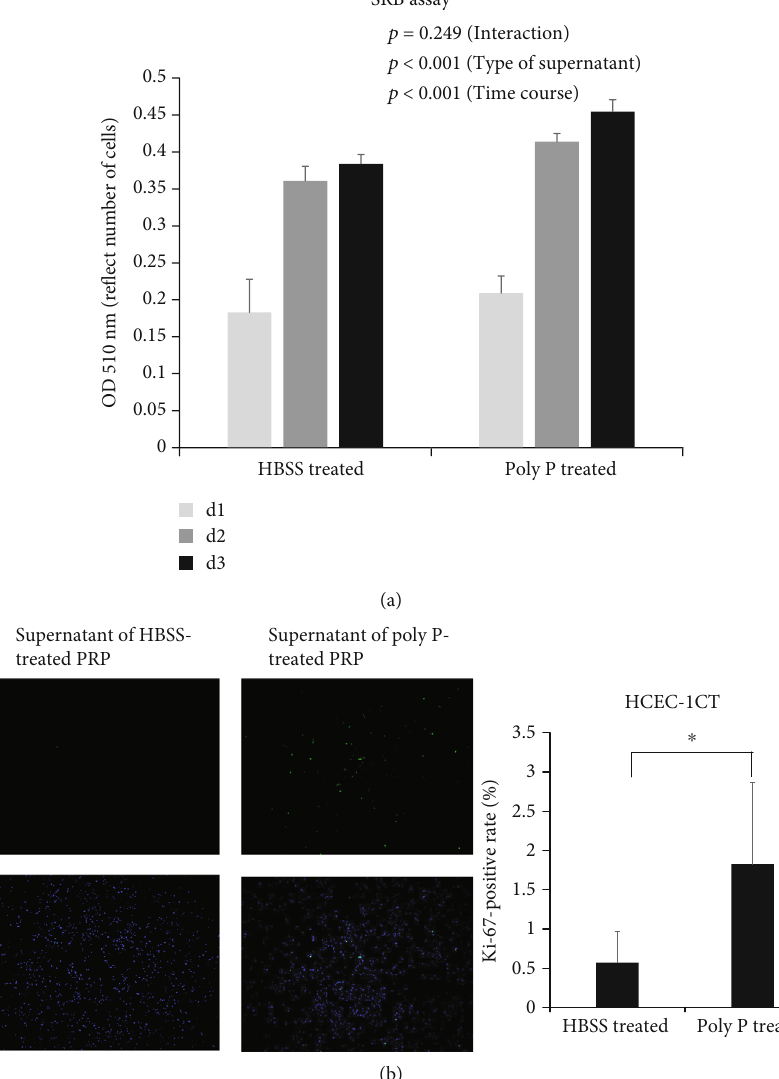
Figure 4: The supernatant of poly P-treated PRP promoted epithelial cell growth. An SRB assay showed that the supernatant of poly P-treated PRP signi fi cantly promoted cell growth (a) according to a two-factor repeated measure ANOVA analysis. Immunocytochemistry of ki-67 showed that the ki67-positive cells were signi fi cantly increased by treatment with the supernatant of poly P-treated PRP (b). The error bars and numbers show the standard deviation. ∗ P < 0 : 05 by Student ’ s t